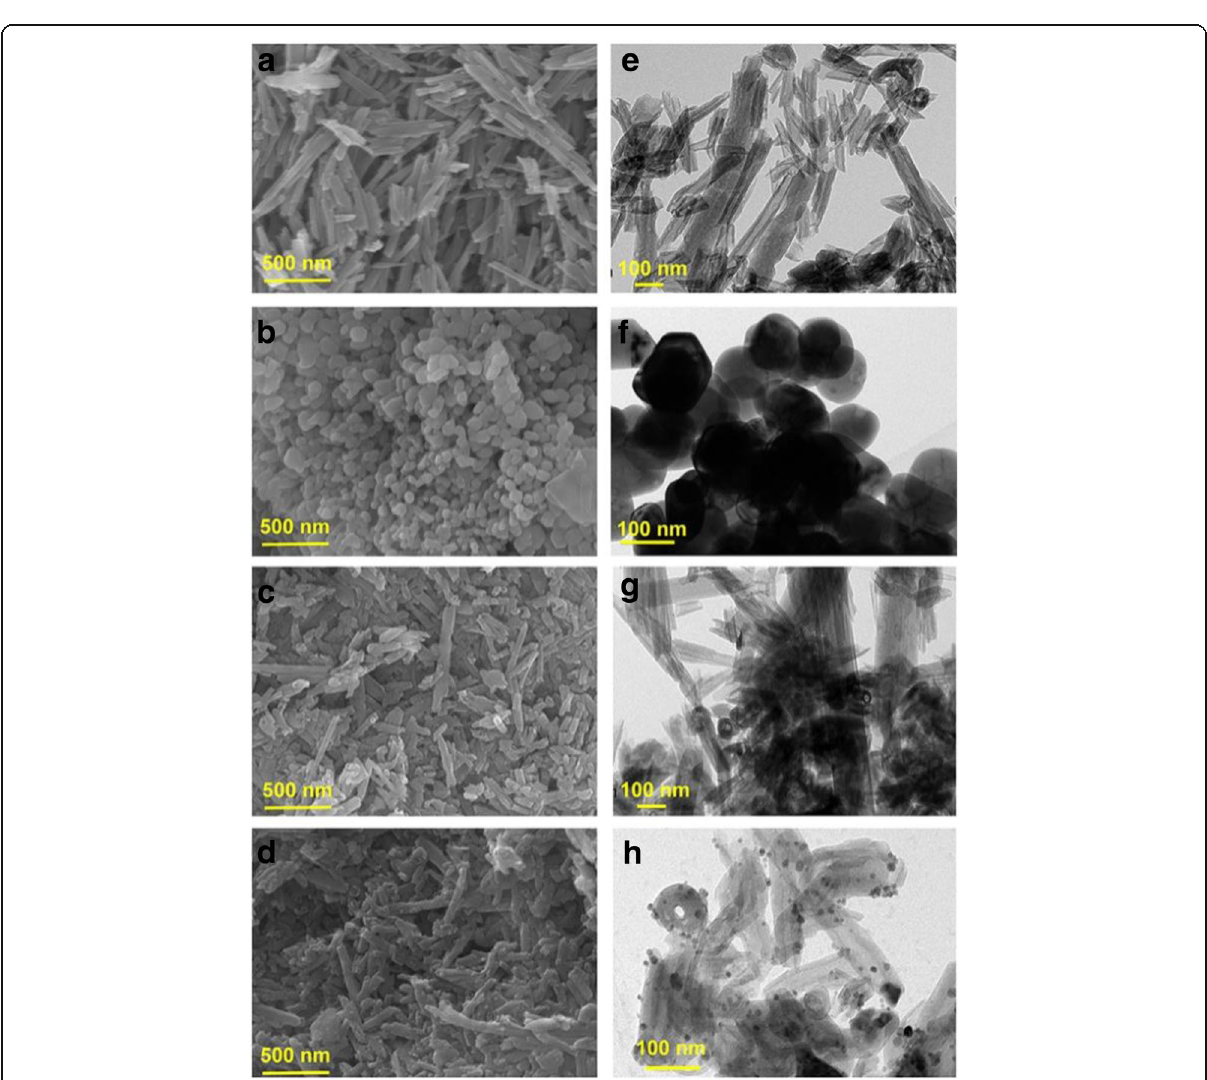
Fig. 2 SEM images of a HNTs, b ZnO, c ZnO/HNTs, and d Ag-ZnO/HNTs; TEM images of e HNTs, f ZnO, g ZnO/HNTs, and h Ag-ZnO/HNTs,